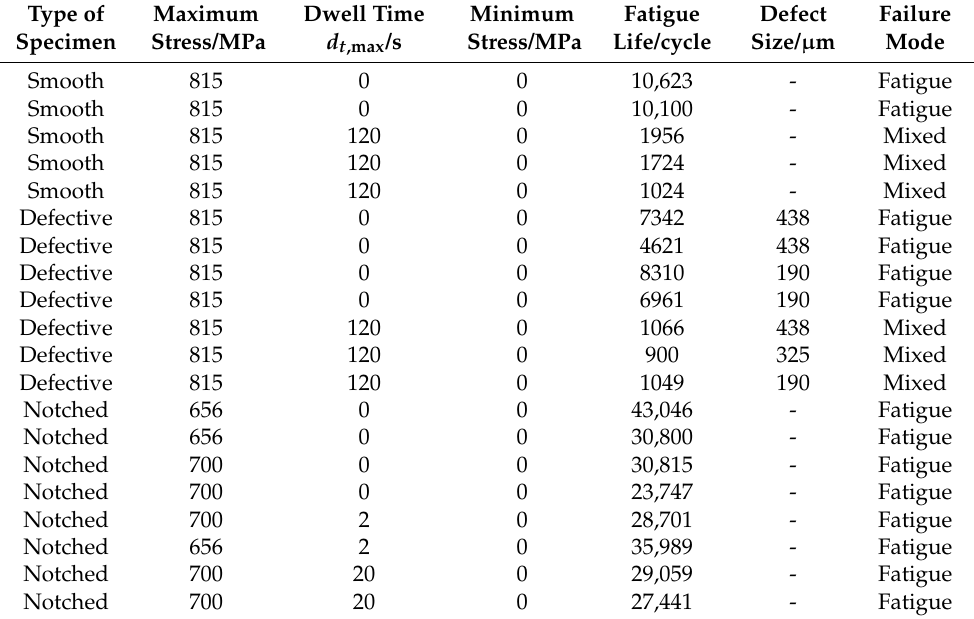
Table 2. Loading information, fatigue life and failure mode for the tested